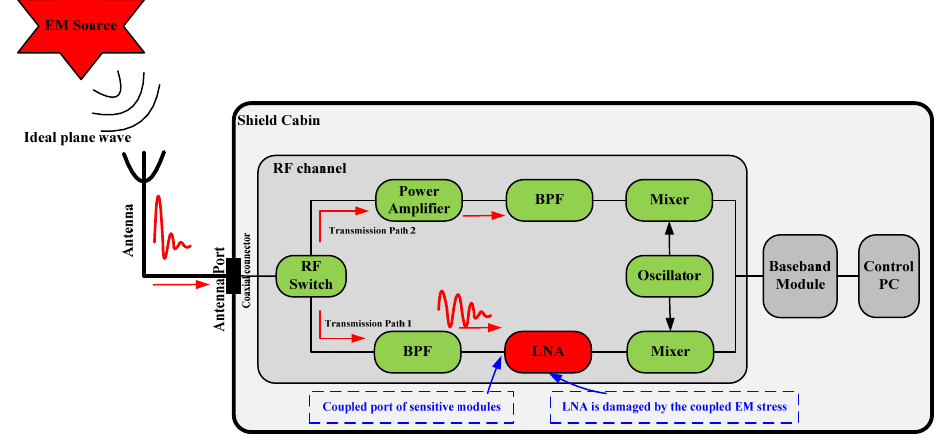
Figure 1. EMP coupling on wireless RF front-end circuits.